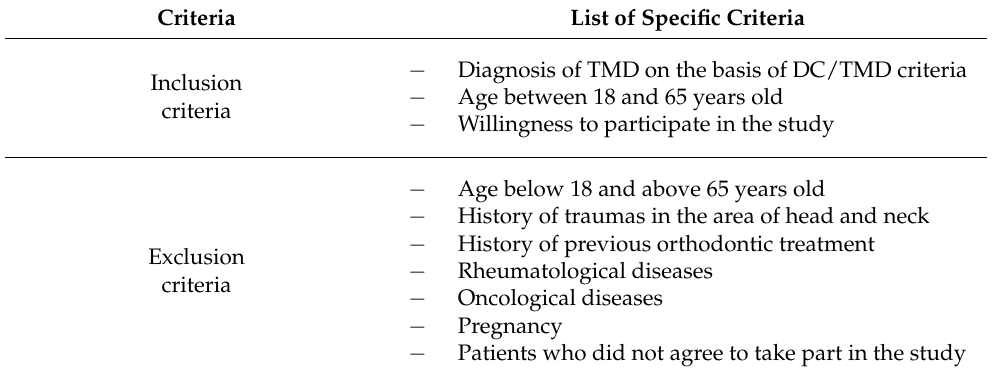
Table 1. Inclusion and exclusion criteria for the study